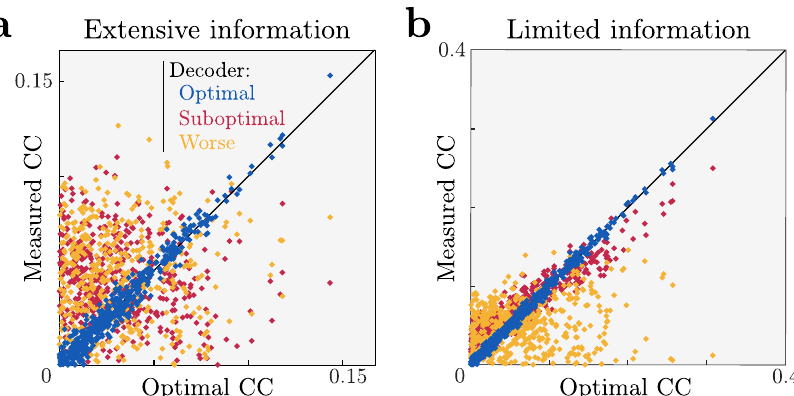
Fig. 4 Information-limiting noise makes a network more robust to suboptimal decoding. a A simulated optimal decoder produces measured choice correlations that match our optimal predictions (blue, on diagonal). In contrast, when a noise covariance Γ 0 permits the population to have extensive information, then a suboptimal decoder can exhibits a pattern of choice correlations that does not match the prediction of optimal decoding. Here we show two suboptimal decoders, one that is blind to higher-order correlations ( w / F 0 , red), and another ‘ worse ’ decoder that has the same weights but with 40% random sign fl ips (green). As in Fig. 5, horizontal axis shows optimal choice correlations (Eq. (7)) and vertical axis shows measured choice correlations (Eq. (5)). b When information is limited, the same decoding weights may be less detrimental, and thus exhibit a similar pattern of choice correlations as an optimal decoder (red), or if they are suf fi ciently bad they may retain a suboptimal pattern of choice correlations